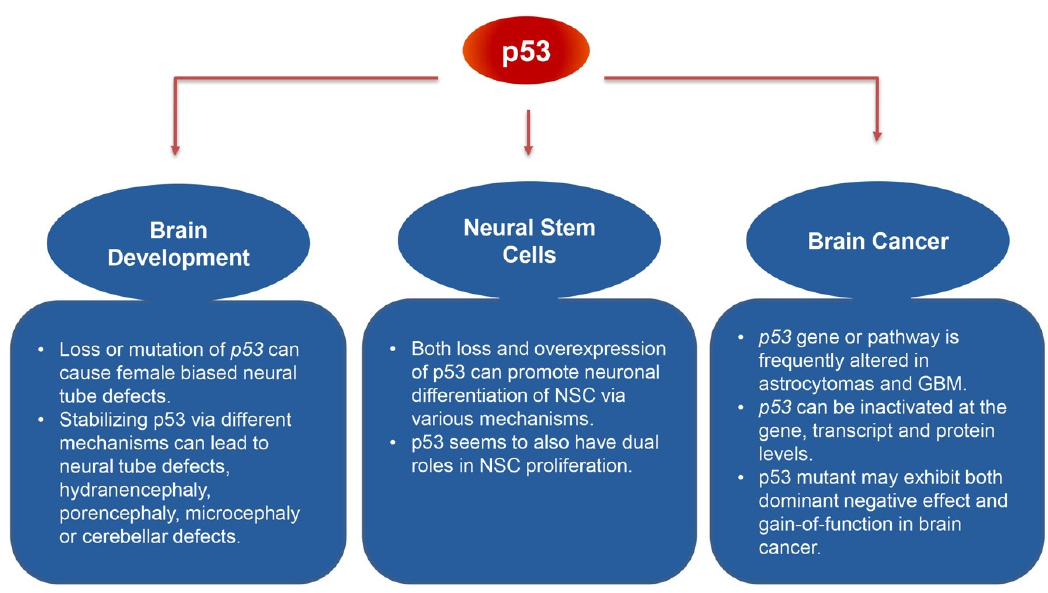
Figure 1. Flow chart outlining the three main topics of this review (p53 ′ s functions in brain development, neural stem cell regulation and brain cancer), and the major specifics discussed underneath each topic.